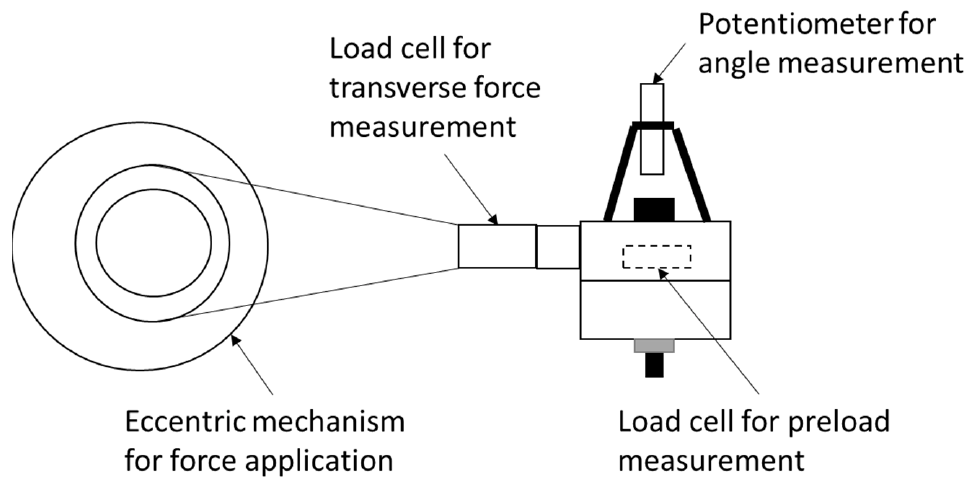
Figure 1. Schematic diagram of Junker apparatus used to apply vibrational loading to the bolted connections.